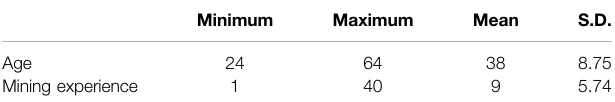
Figure 3 ). Prior to training, a guide sheet on how to use the gamepad was given to each participant.